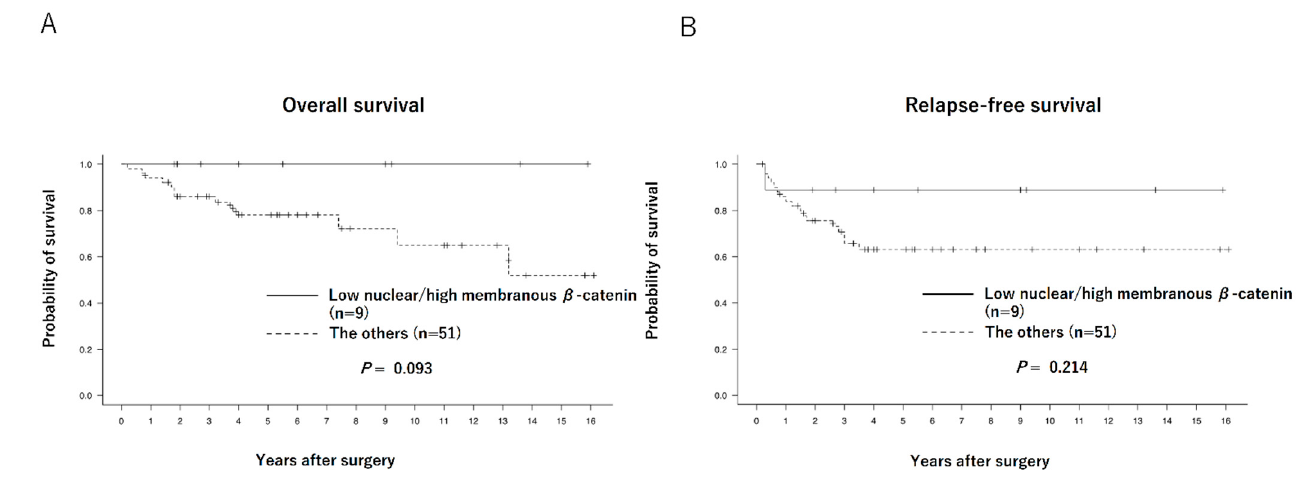
Figure 3. Overall survival curves ( A ) and relapse-free survival curves ( B ) of patients with low nuclear/high membranous β -catenin expression ( n = 9) and others ( n = 51).